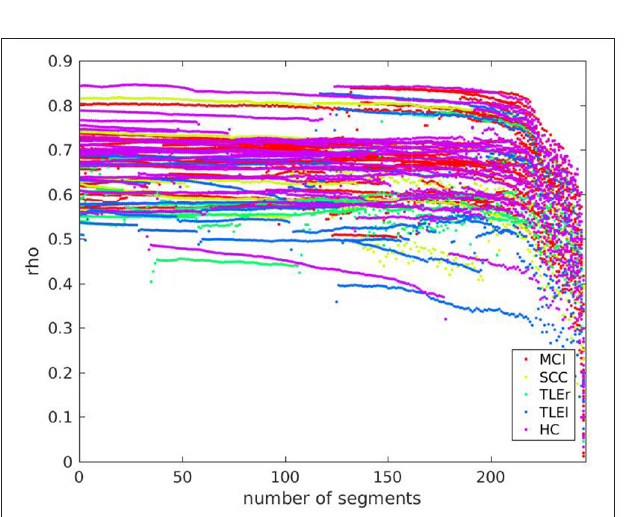
FIGURE 6 | Scatter plot of test-retest reliabilities for full frequency directed transfer function vs. number of excluded segments of size 500 ms. The x-axis represents the number of segments that were cut out from the end of the signal. Dots represent values of individual participants. Colors indicate groups MCI, mild cognitive impairment; SCC, subjective cognitive complaints; TLEr, temporal lobe epilepsy with focus on the right hemisphere; TLEl, temporal lobe epilepsy with focus on the left hemisphere; HC, healthy controls.